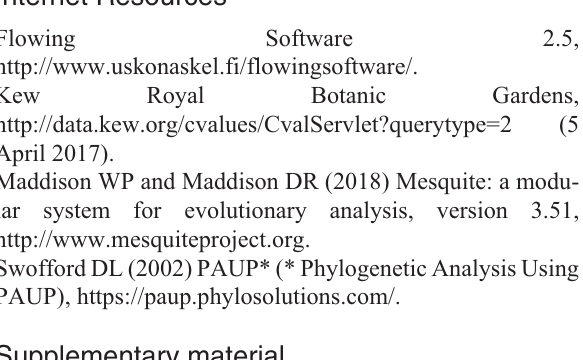
Table S1- Information about Stylosanthes species. Figure S1- Phylogenetic analysis based on